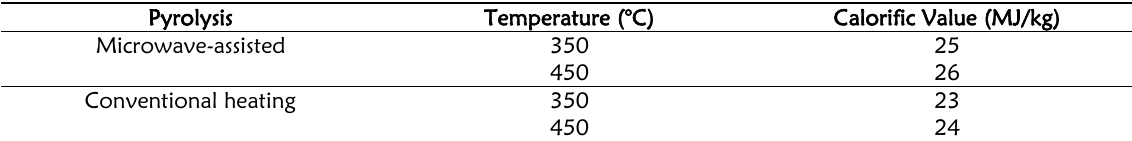
Table 3: Expected calorific value result of pyrolysis bio-oil at different conversion temperature Pyrolysis Temperature (°C) Calorific Value (MJ/kg) Microwave-assisted 350 450 Conventional heating 350 450